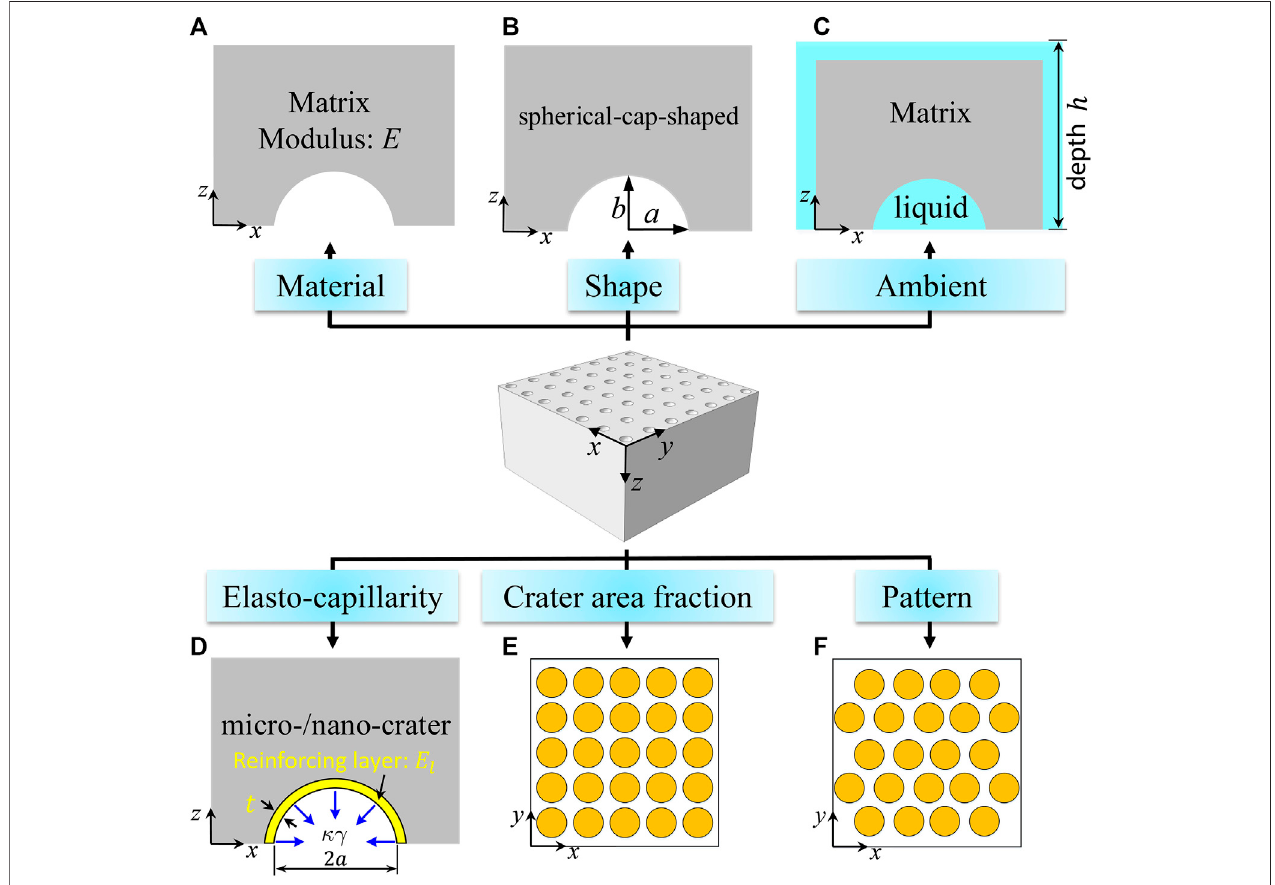
FIGURE5| Sixfactorsthataffectthesuctioneffectsofcraterarraysdiscussedinthisreviewarticle: (A) matrixmodulus; (B) cratershape, (C) ambientenvironment; (D) elasto-capillarity at small length scale; (E) crater area fraction; (F) the pattern of a crater array.